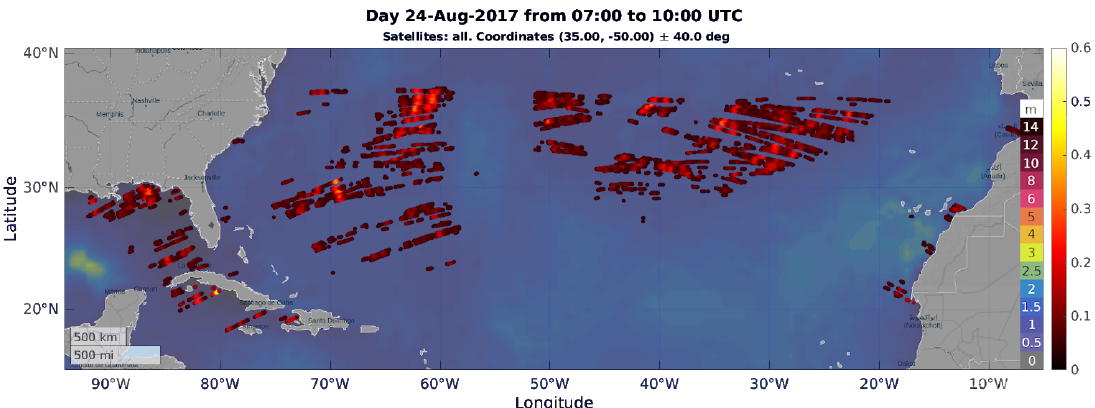
Figure 10. Filtered high S 4 values overlaid with the wave height for 24 August 2017, showing the calm sea